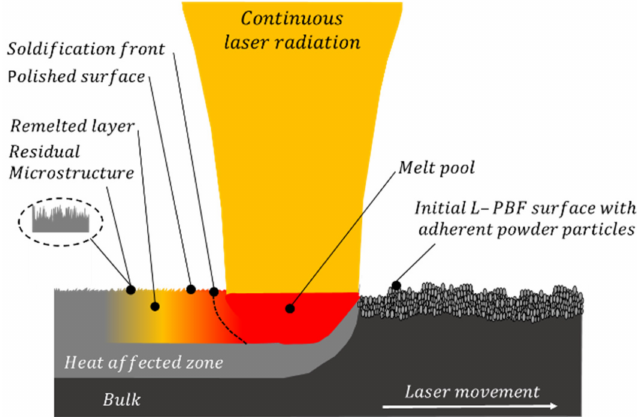
Figure 1. Schematic illustration of laser macro polishing with continuous laser